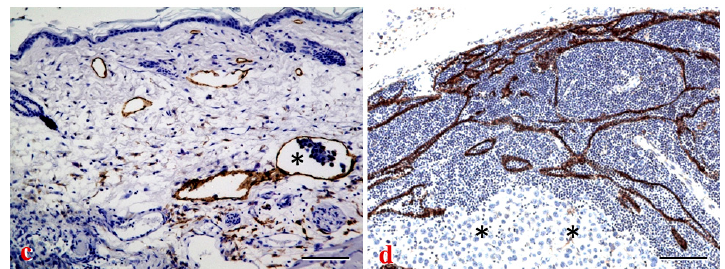
Figure 3. Lymphatics in normal and tumor tissues. ( a , b ) Lymphatic networks with 5 ′ -Nase staining are featured by blind ends (arrowheads) and valves (arrows) in the intermuscular layer of the jejunum ( a ) and the pleural membrane ( b ), backscattered electron imaging in scanning electron microscopy) of monkeys; ( c , d ) In the mouse melanoma model, lymphatic vessel endothelial hyaluronan receptor (LYVE-1) staining shows increased lymphatic vessels in the skin ( c ), and increased subcapsular and cortical lymphatic sinuses in the lymph node ( d ). The metastatic cells invade lymphatic vessels in the subdermal tissue (( c ), asterisk) and aggregate in the LN parenchyma (( d ), asterisks). Bars: ( a ) 500 μ m; ( b ) 150 μ m; ( c , d ) 100 μ m.